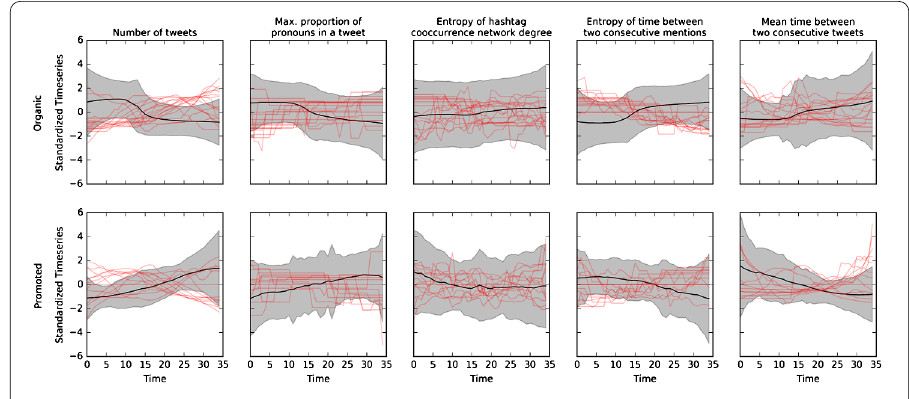
Figure 9 Comparison between feature time series of misclassified and correctly classified trends. Time series of the top five features (columns) for promoted (top) and organic (bottom) trends in the D = 40 detection task. The black lines and gray areas represent the average and 95% confidence intervals of time series for correctly classified trends. Time series of misclassified trends are shown in red. Misclassified organic trends (false positives) are: #bobsantigoldlive , #evildead , #galaxyfamily , #gethappy , #madmen , #makeboringbrilliant , #nyias , #oneboston , #stingray , #thewalkingdead